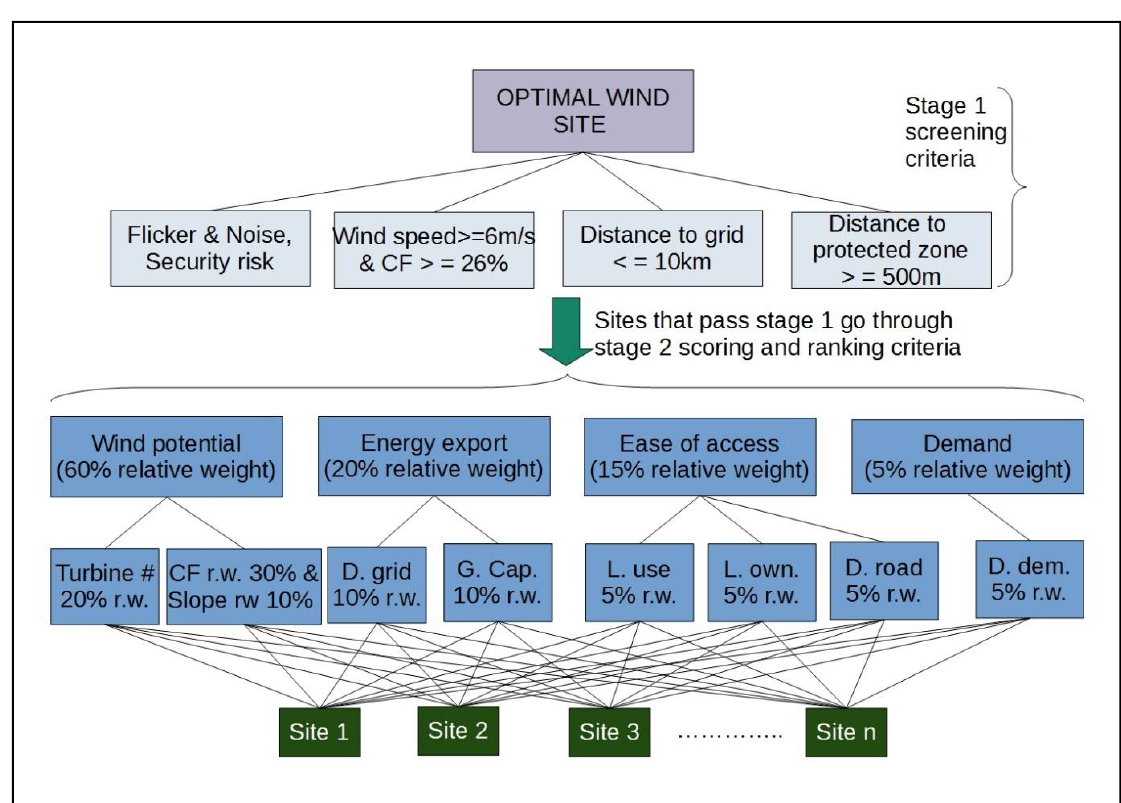
Figure A1. Graphic showing the 2-stage hierarchy structure for optimal onshore wind site selection. Abbreviations: Turbines#—number of turbines, CF—capacity factor, r.w.—relative weight, D. grid—distance to grid, G. cap.—grid ca- pacity, L. use—land use, L. own—land ownership, D. road—distance to road, D. dem.—distance to demand center, r.w.—relative weight. Table A2. Table showing balanced scoring and ranking matrix complete results.